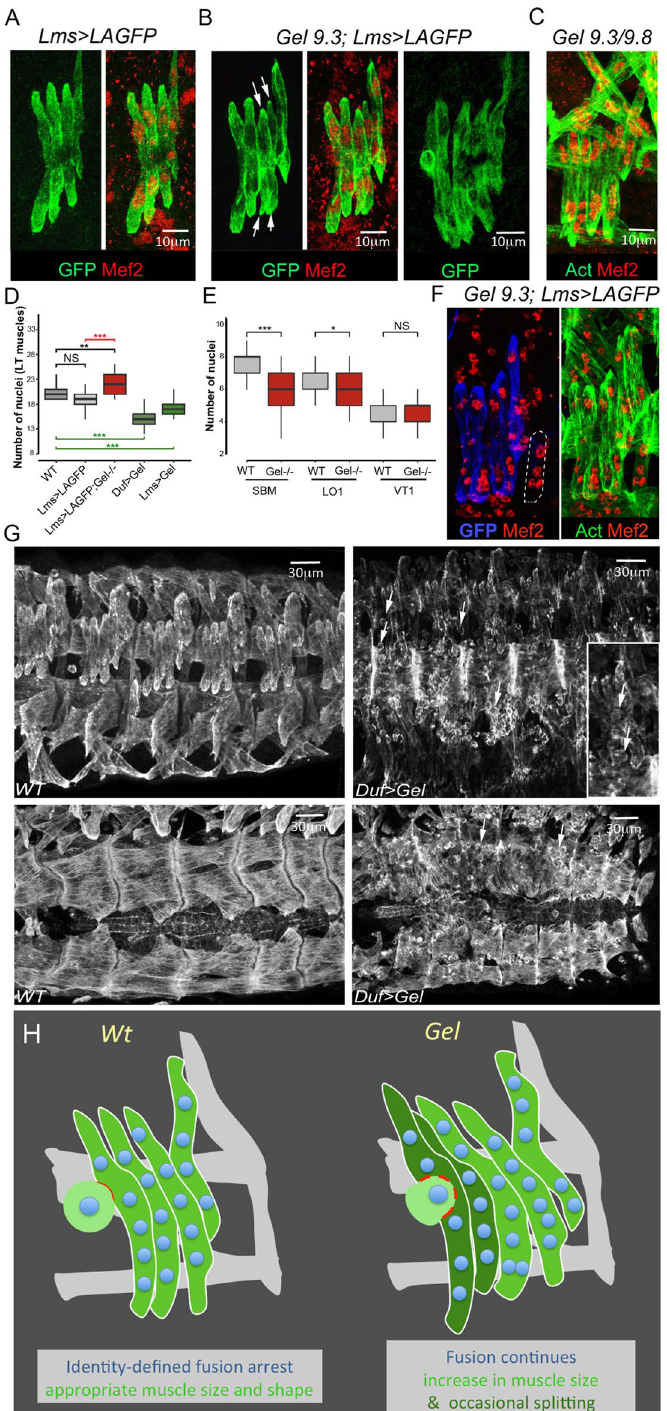
Figure 6. LT muscle splitting in Gel mutant embryos is due to an excessive myoblast fusion. LT muscle shapes at late stage 15 revealed by anti-GFP staining in Lms > LAGFP sensor line ( A ), in Gel 9.3 context ( B ) and in transheterozygous Gel 9.3/9.8 embryos ( C ). Myonuclei are visualised using anti-Mef2. Arrows indicate LT splitting in Gel homozygous ( B ) and the transheterozygous context ( C ). Late fusion events are observed in Gel 9.3;Lms > LAGFP embryos ( B , right panel). ( D ) Number of Mef2 positive LT1-LT4 nuclei is increased in Gel mutants ( n = 30) compared to wild type ( n = 13) and Lms > LAGFP contexts ( n = 43). An opposite effect (reduced number of nuclei) is observed in LTs of Duf > Gel ( n = 80) or Lms > Gel embryos ( n = 65) (green boxplots). A Wilcoxon-Mann–Whitney test was applied to assess statistical significance. *** p < 0.001 ( E ). Excessive fusion in Gel mutant with split LTs induce a decrease in the number of nuclei in neighbouring SBM and LO1 but not in ventrally located VT1 muscle. For SBM: WT ( n = 66), Gel 9.3 ( n = 110), for LO1: WT ( n = 58), Gel 9.3 ( n = 100), for VT1: WT ( n = 68), Gel 9.3 ( n = 93). A Wilcoxon-Mann–Whitney test was applied to assess statistical significance. *** p < 0.001. ( F ) Reduced number of nuclei in SBM muscle (dotted line) of Gel 9 .3 embryo (four instead of seven in the wild type ). ( G ) Lateral and dorsal views of anti-actin stained stage 16 wild type and Duf > Gel embryos (right panels) showing myoblast fusion defects. Arrows point to unfused myoblasts. ( H ) A scheme of Gel loss of function